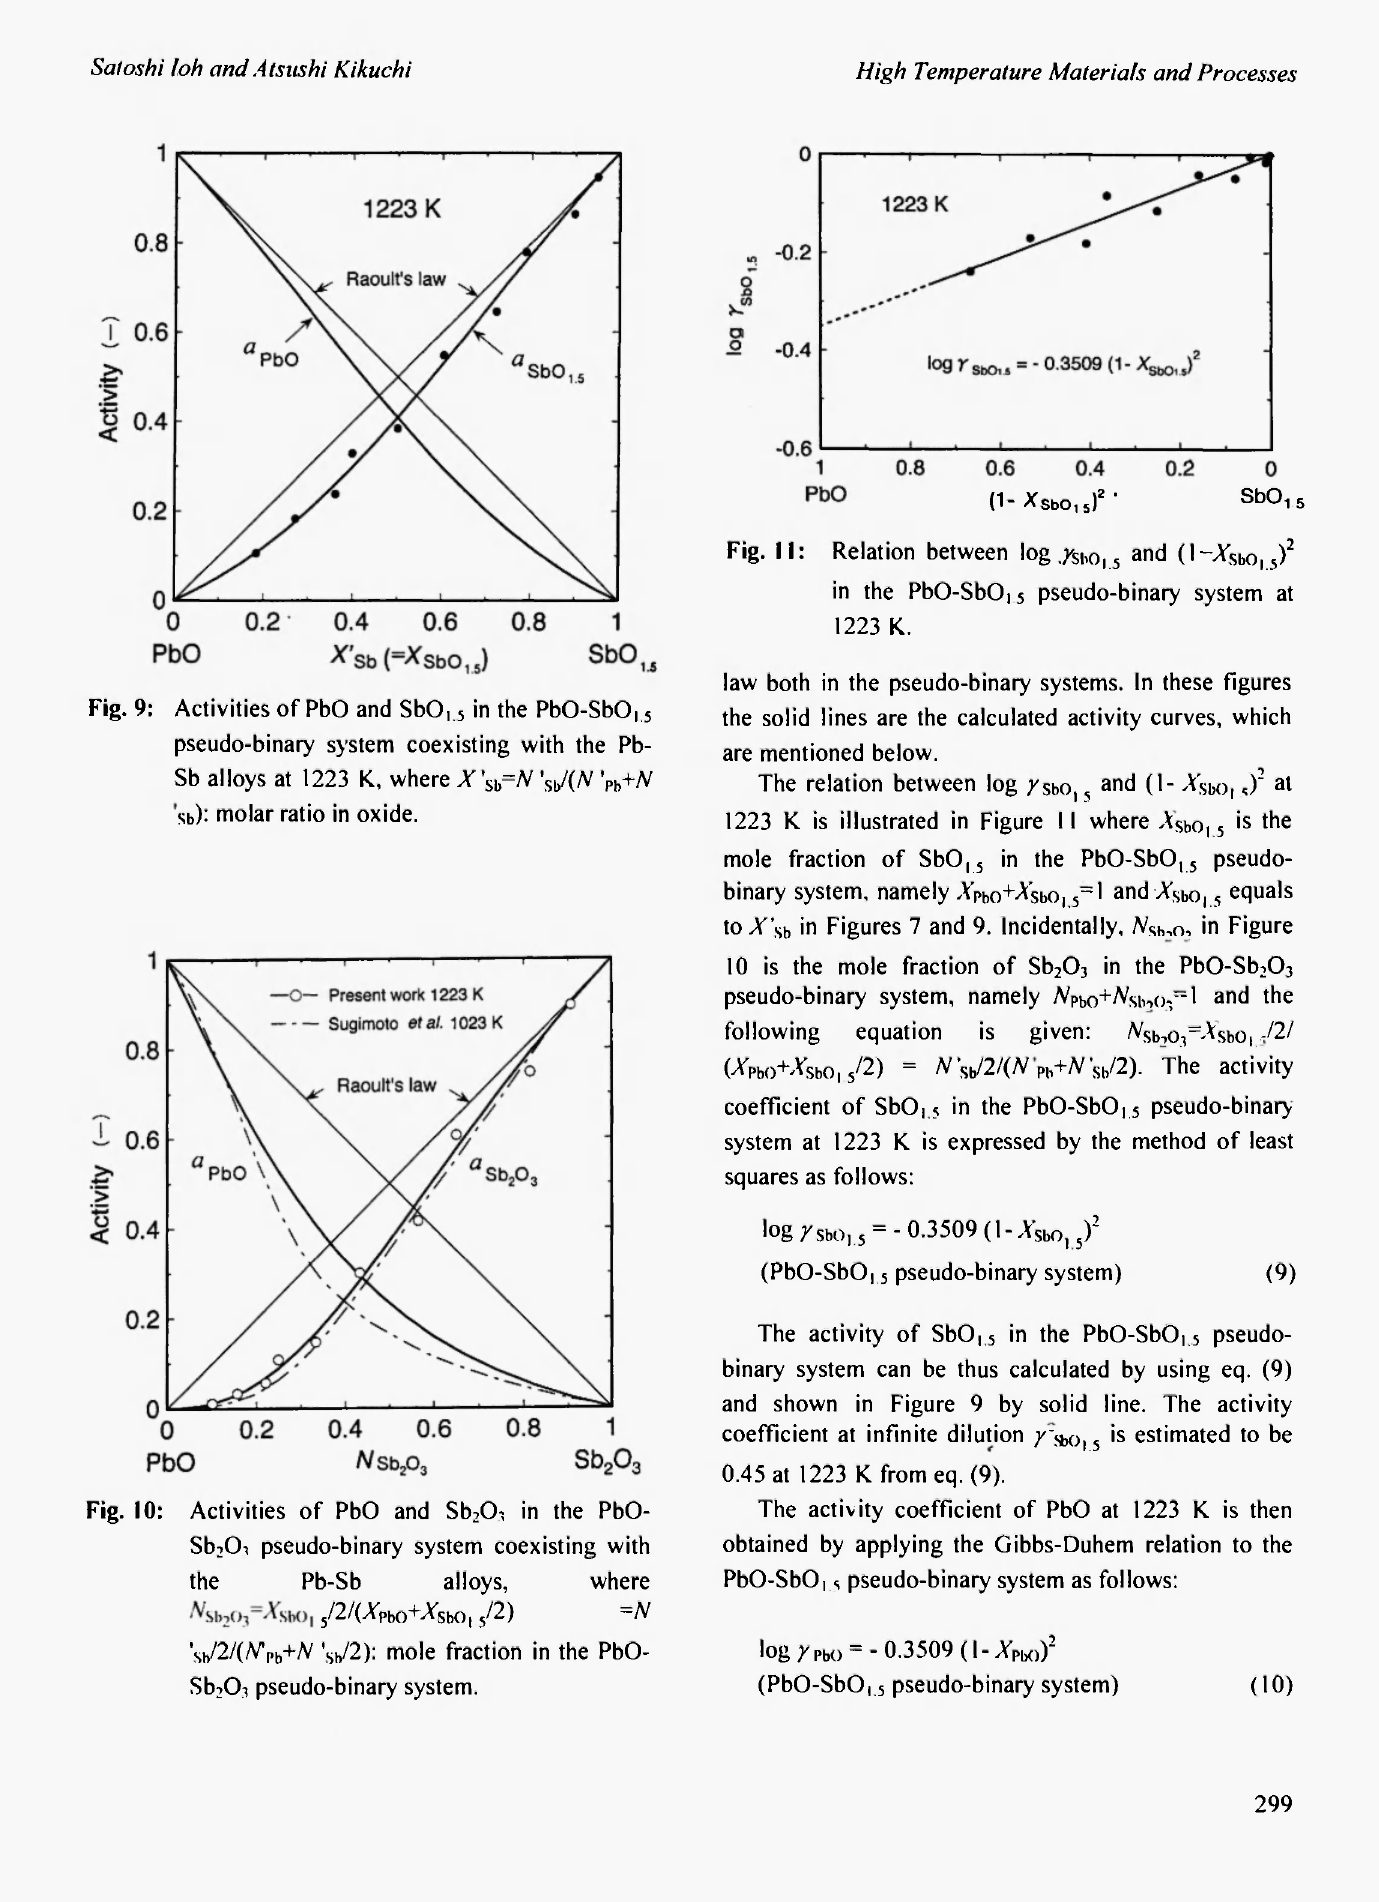
Fig. 11: Relation between log .y S i.o l 5 and (l-Xsbo, ,) 2